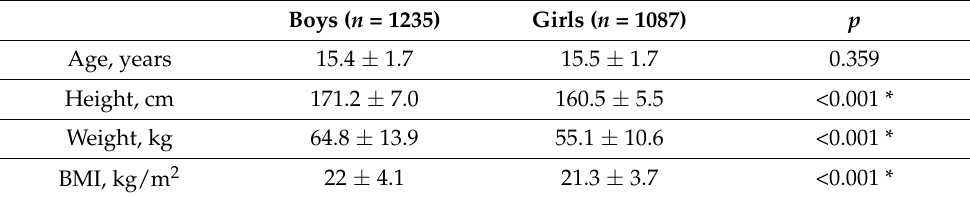
Table 1. General characteristics of participants.